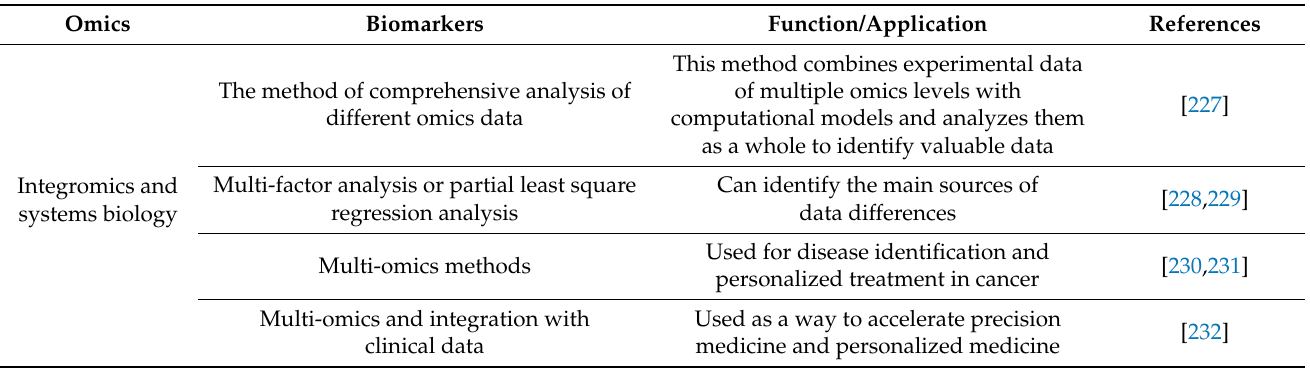
Table 6. Potential aging biomarkers identified in integromics and systems biology